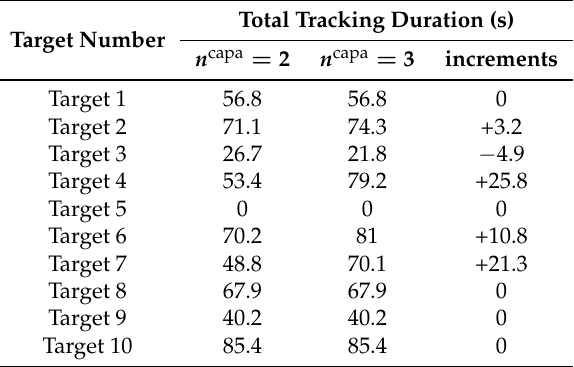
Figure 6. Optimal scheduling assignment result for 10 targets and three radars with different simultaneous tracking capability. ( a ) When the radars can track two targets simultaneously ( n capa = 2). ( b ) When the radars can track three targets simultaneously ( n capa = 3). Table 4. Tracking duration time according to simultaneous tracking